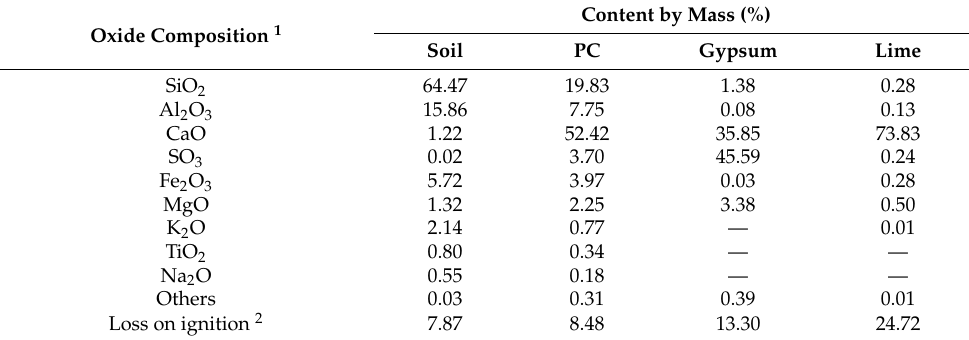
Table 2. Oxide composition of the tested soil and each component of the